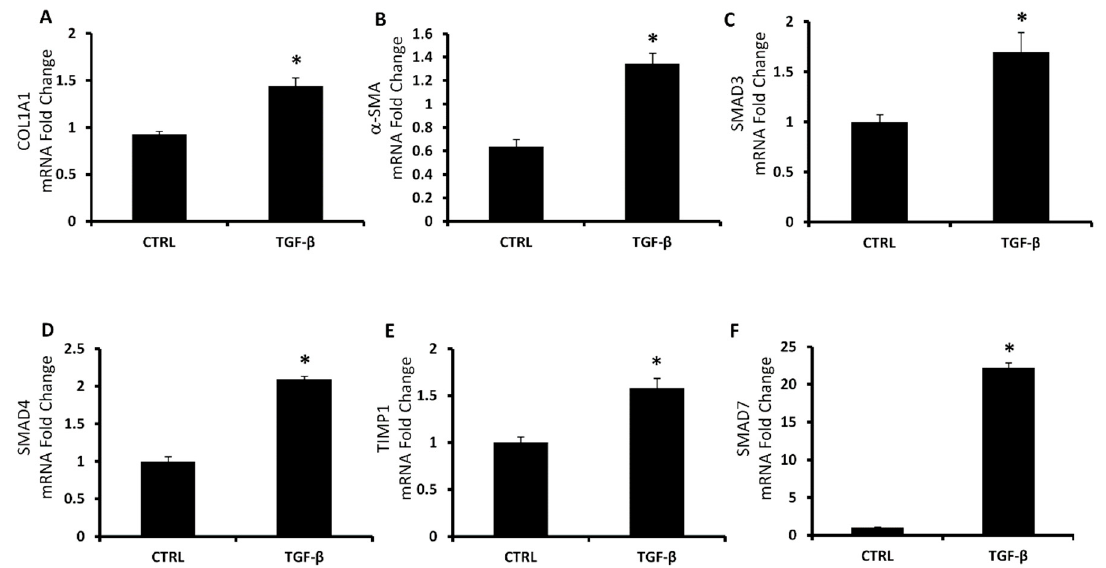
Figure 4. mRNA expression of fibrosis pathway. COL1A1 ( A ) α -SMA, ( B ) SMAD3, ( C ) SMAD4, ( D ) Table 1 . and SMAD7, and ( E ) of LX2 control cells and cells treated with TGF- β 5 ng. Results are mean ± SD, * p < 0.05 vs. CTRL.